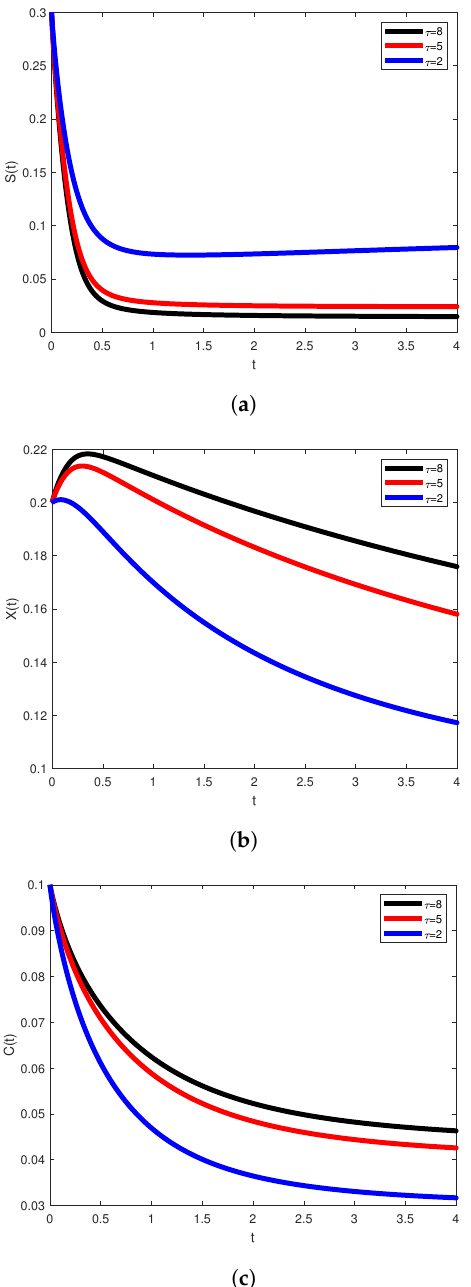
Figure 4. Numerical simulation of the oxygen saturation concentration, the substrate concentration, and the microorganism concentration for different values of residence time. The value of the pa- rameters is stated in Table 1. ( a ) Dynamic of the concentration of substrate with different values of τ . ( b ) Dynamic of the substrate concentration with different values of τ . ( c ) Dynamic of the microorganism concentration with different values of τ